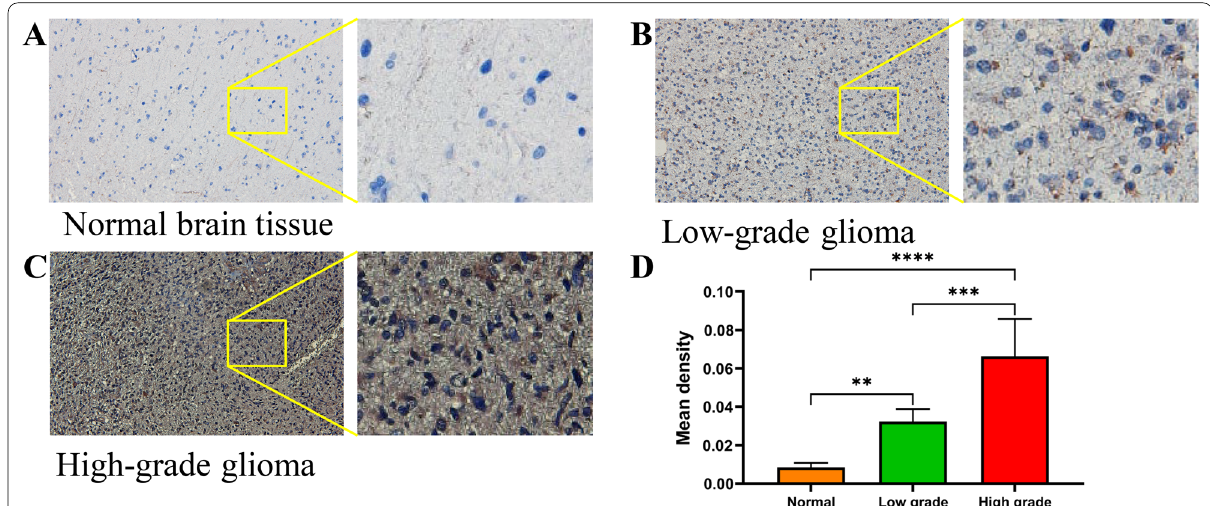
Fig. 2 The protein expression of GINS4 was obviously increased in glioma. A The staining of GINS4 in normal brain tissue; B lightly positive staining of GINS4 in low grade glioma; C strongly positive staining of GINS4 in high grade glioma; D the statistical analysis of GINS4 expression in glioma